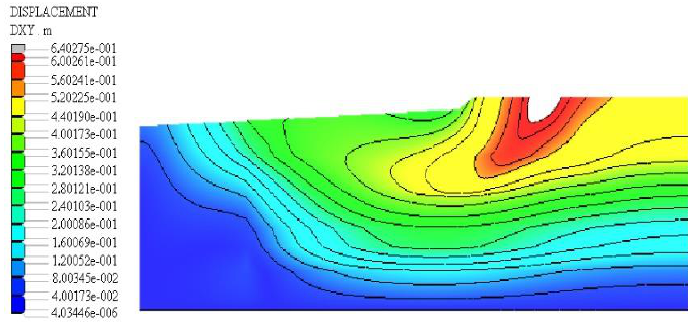
Figure 8. The finite element analysis result.